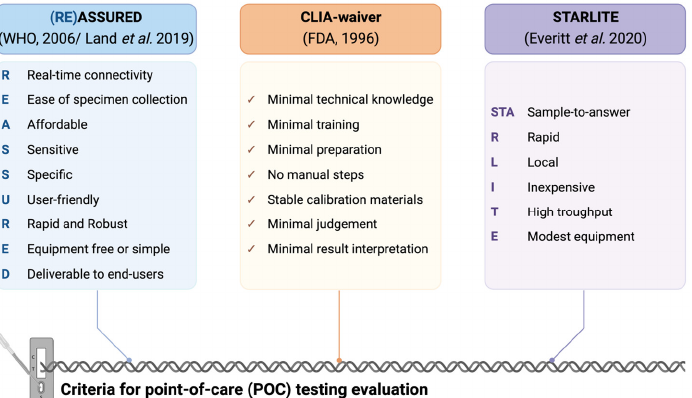
Figure 1. Requirements of the (RE)ASSURED [17,18], CLIA [19] and STARLITE [14] criteria for point-of-care diagnostics. Created with Biorender.com (accessed on 10 October 2022).